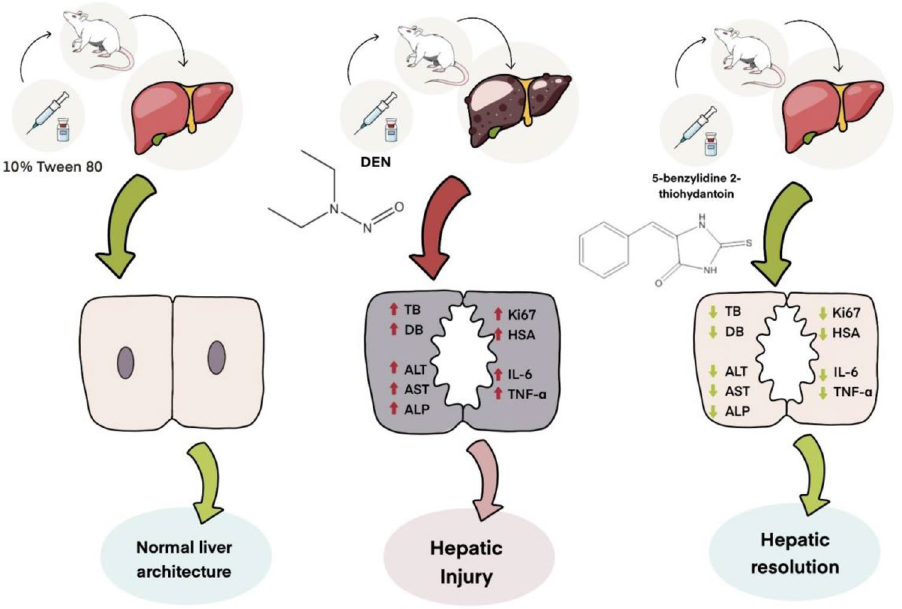
Figure 9. The effect of 5-benzylidine-2-thiohydantoin on liver injury induced by diethylnitrosamine. DEN: Diethylnitrosamine, TNFα: tumor necrosis factor alpha and IL-6: Interleukin 6. TB: total bilirubin, DB: direct bilirubin, AST: acetate aminotransferase, ALT: alanine aminotransferase, ALP: alkaline